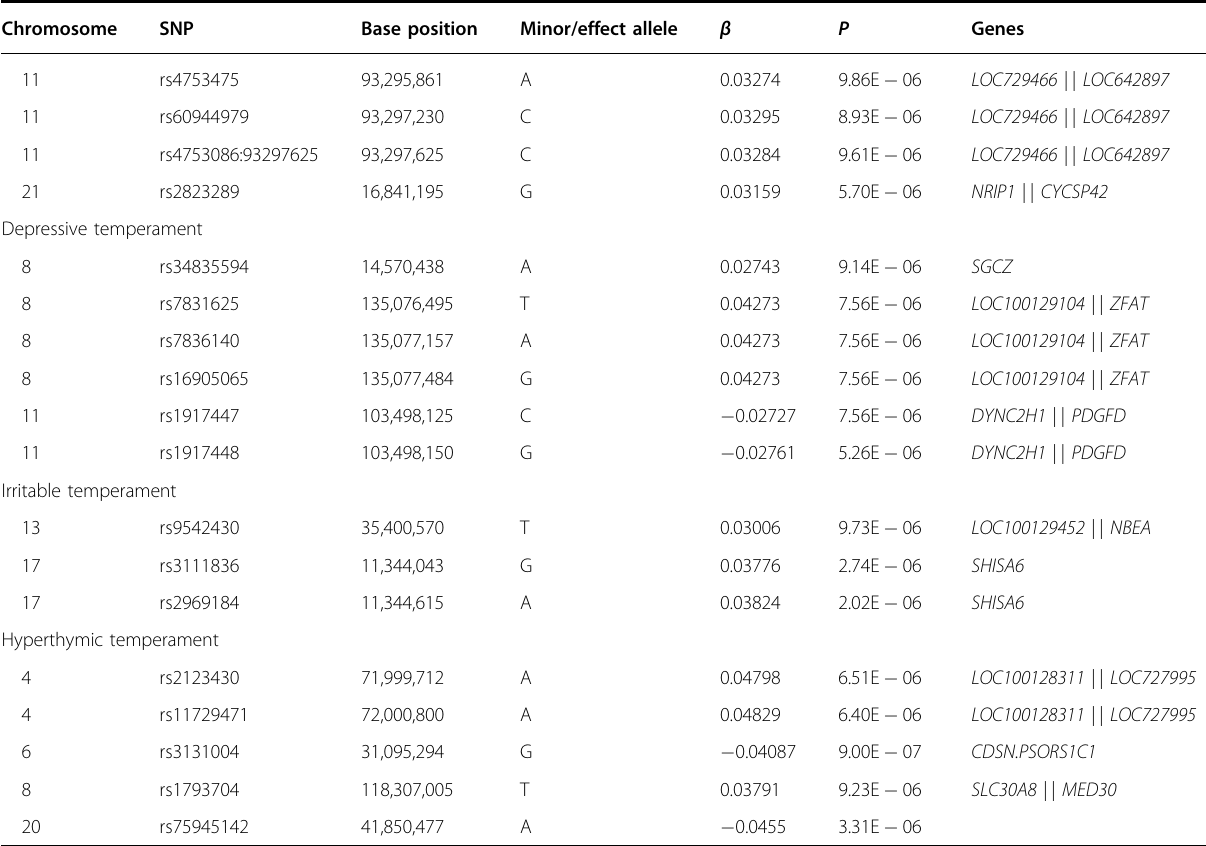
Fig. 2-II. No genes reached genome-wide signi fi cance after correction for multiple testing in case of any of the tem- peraments; however, several genes with suggestive sig- ni fi cance were identi fi ed for each affective temperament. Suggestively signi fi cant fi ndings in gene-based tests for anxious temperament In case of anxious temperament, for the QQ plot, see Supplementary Fig. S6; INSL5 , FYN, HCG22 , PIP , MIR1251 , HECTD1 , ROGDI , SEPT12 , SMIM22 and MIR454 genes survived the threshold for suggestive sig- ni fi cance after correction for multiple testing (Table 2 and Fig. 2 II-A).